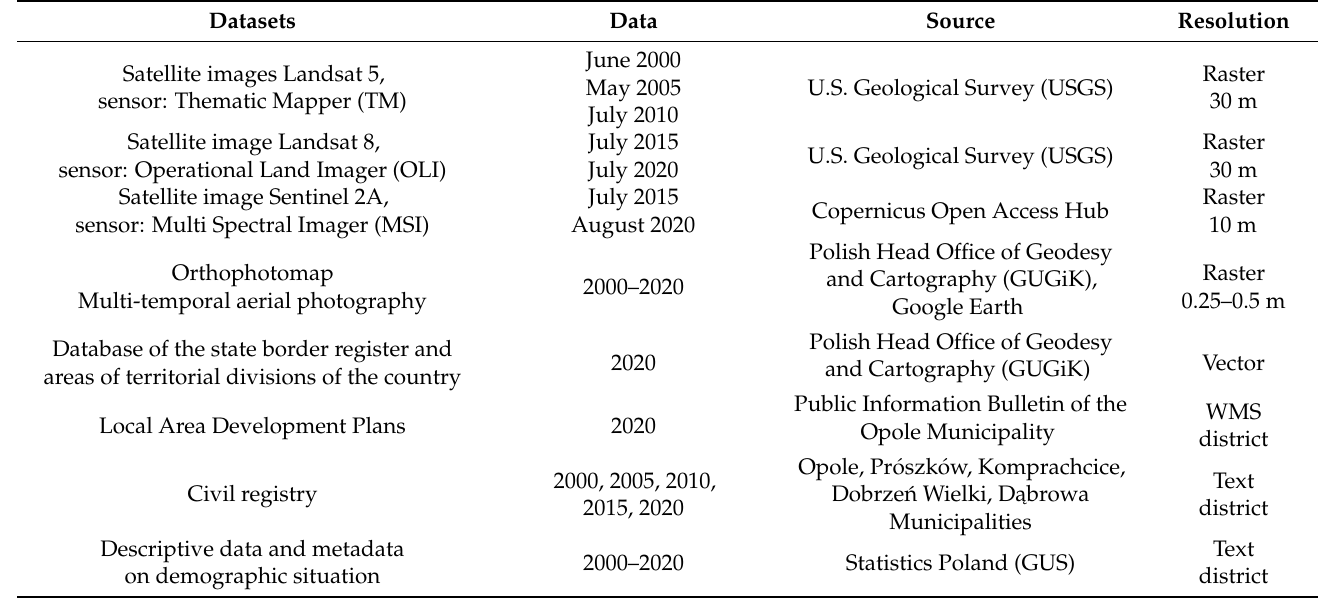
Table 1. Datasets used in the analysis, their sources and